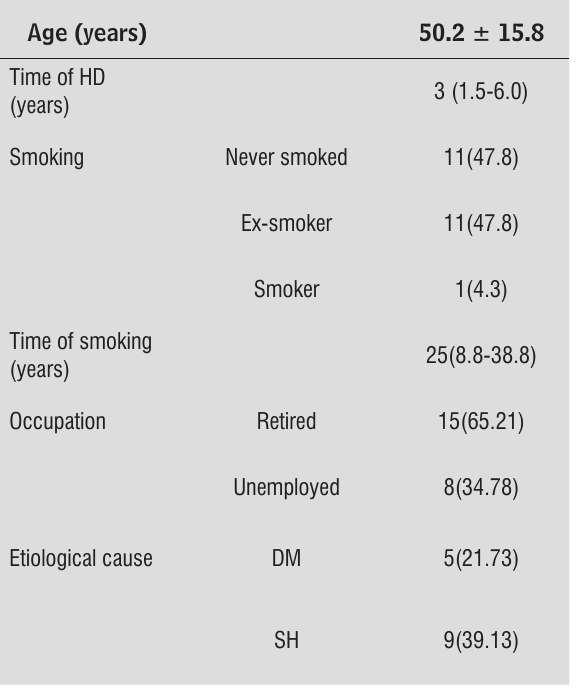
Table 1 - Sociodemographic and clinical characteristics